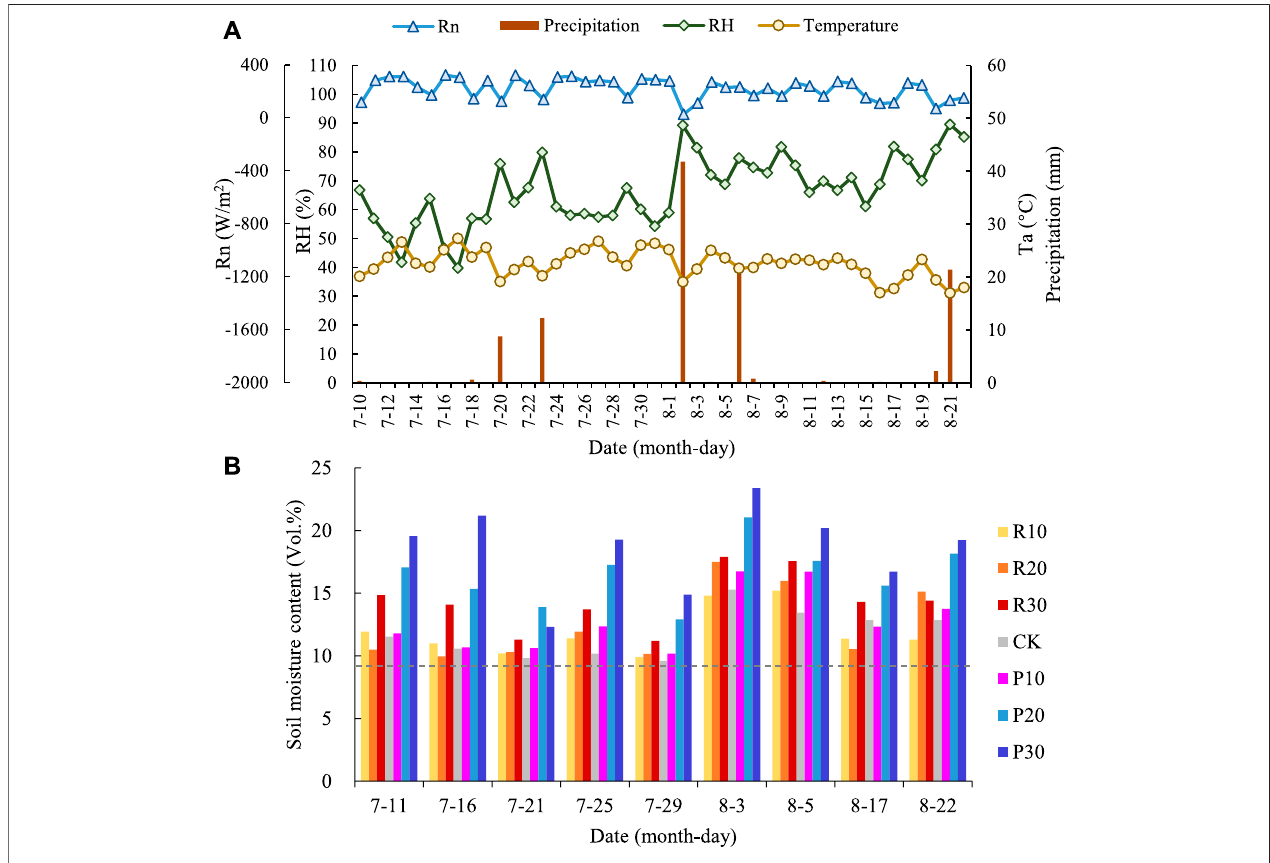
FIGURE 2 | The (A) meteorological data in the experiment. and (B) soil moisture content of alfalfa under different irrigation events during the date of observation. Data are presented in approximately fi ve-day intervals, and the gray dot line indicates the permanent wilting point.